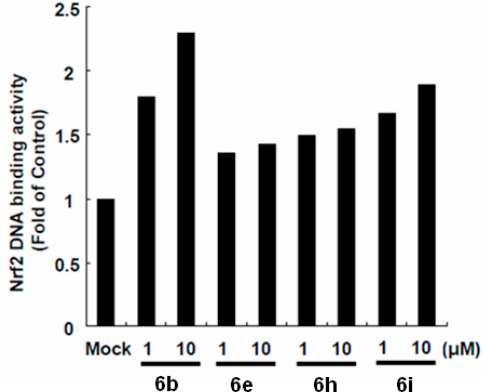
Figure 6. Isoflavones inhibited HCV replication by upregulating Nrf2 expression. Compound 6b , 6e , 6h and 6i stimulated ARE transactivation in Ava-5 cells. The antioxidant response reporter plasmid, p3xARE-Luc, was transfected into Ava-5 cells and then treated with isoflavones (1 and 10 µ M) for 3 days. The relative induction of antioxidant activity was determined by luciferase assay. The activity of untreated Ava-5 cells was considered to be 1.